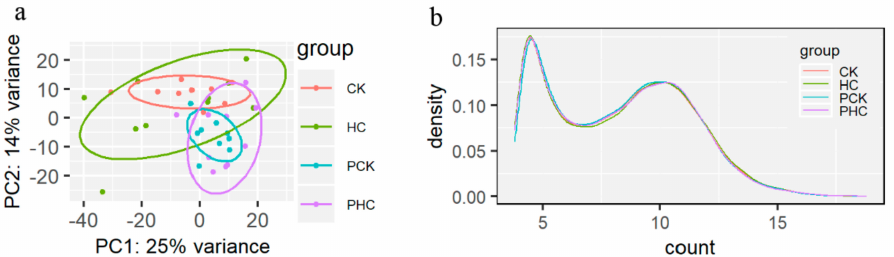
Figure 3. Gene expression patterns and gene level expression abundance among the four groups. ( a ) The principal component analysis (PCA) plot of transformed read counts for each group and ( b ) the density plot of transformed read counts for each group.